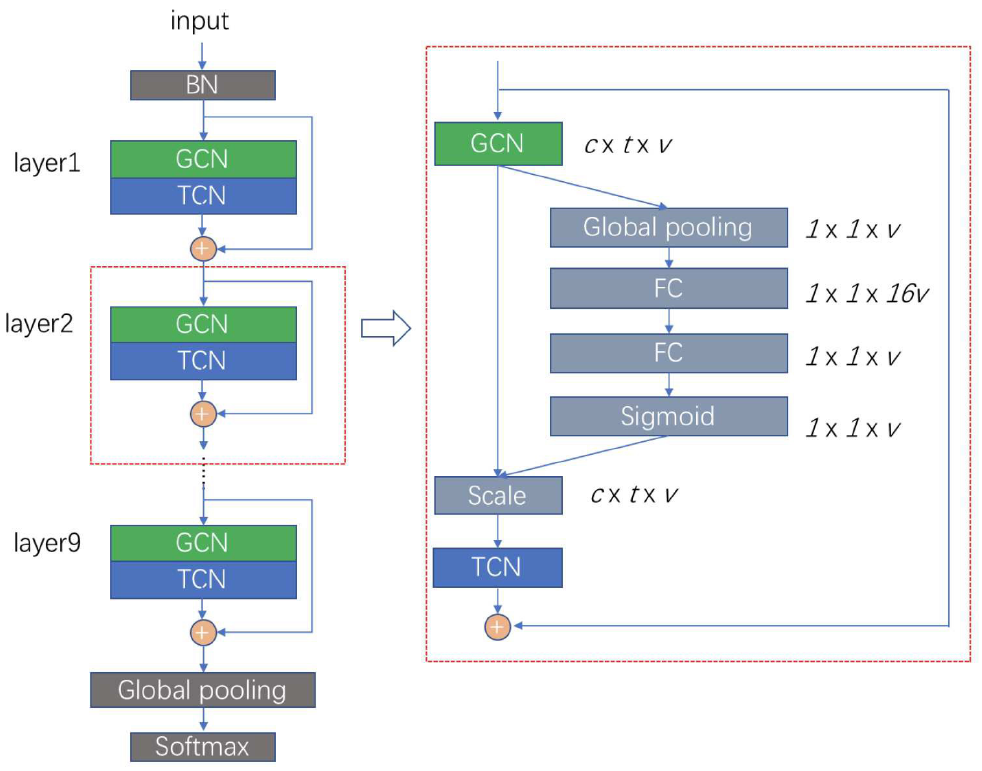
Fig. 2 Structure diagram of NA-STGCN. GCN, graph convolutional neural network; NA-STGCN, node attention spatial–temporal graph convolutional neural